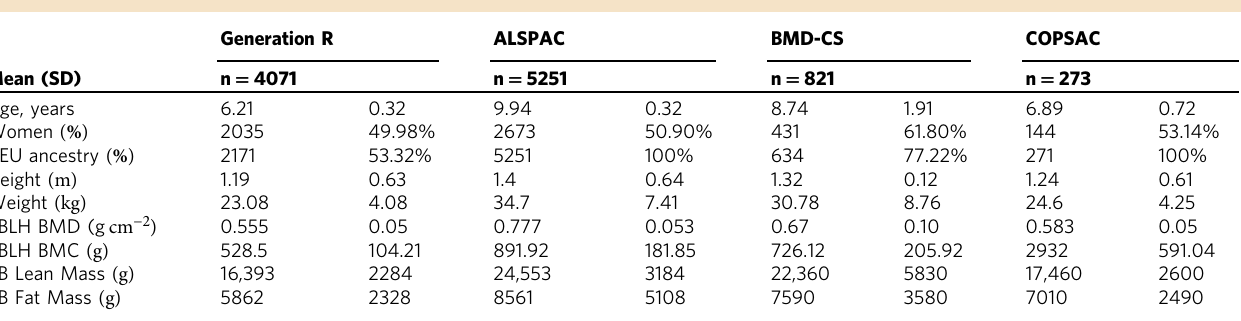
Table 1 Anthropometric characteristics of study participants Generation